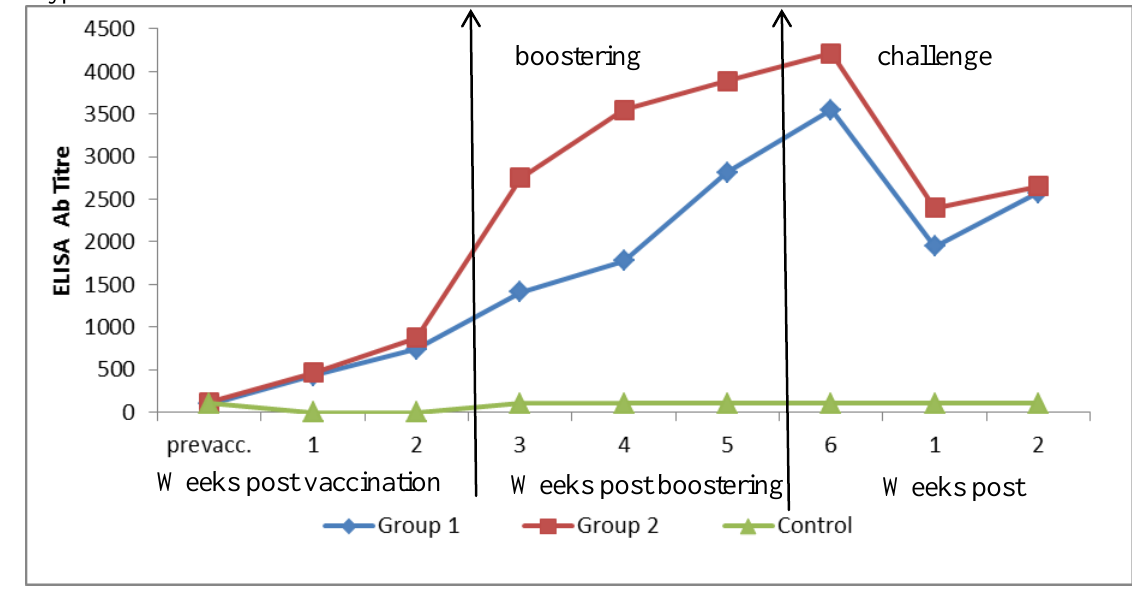
Fig.3: ELISA titer in sera of vaccinated turkey poults using O1antigen and challenged with E.coli serotype O1: